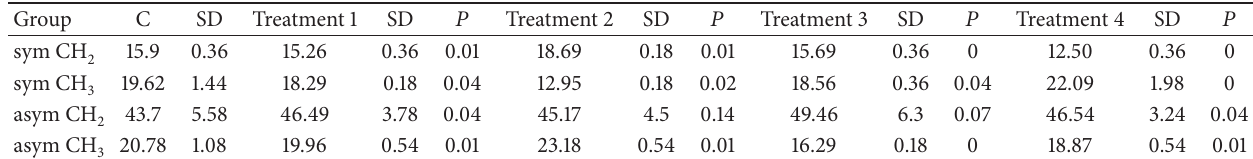
Table 2: Curve-fitting results of bands in 3000–2800 cm − 1